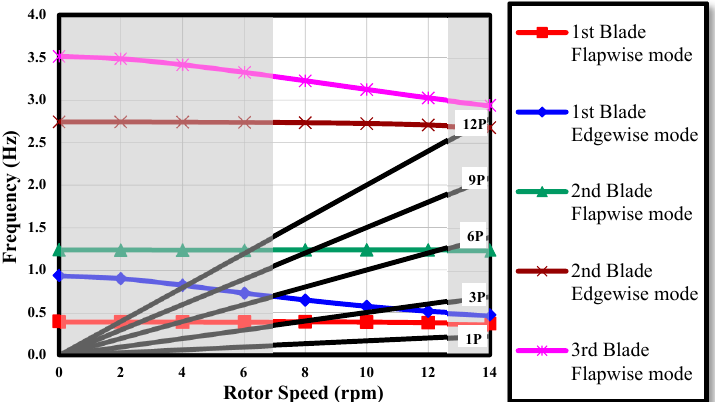
Figure 9. Campbell diagram of the blade (FE model).